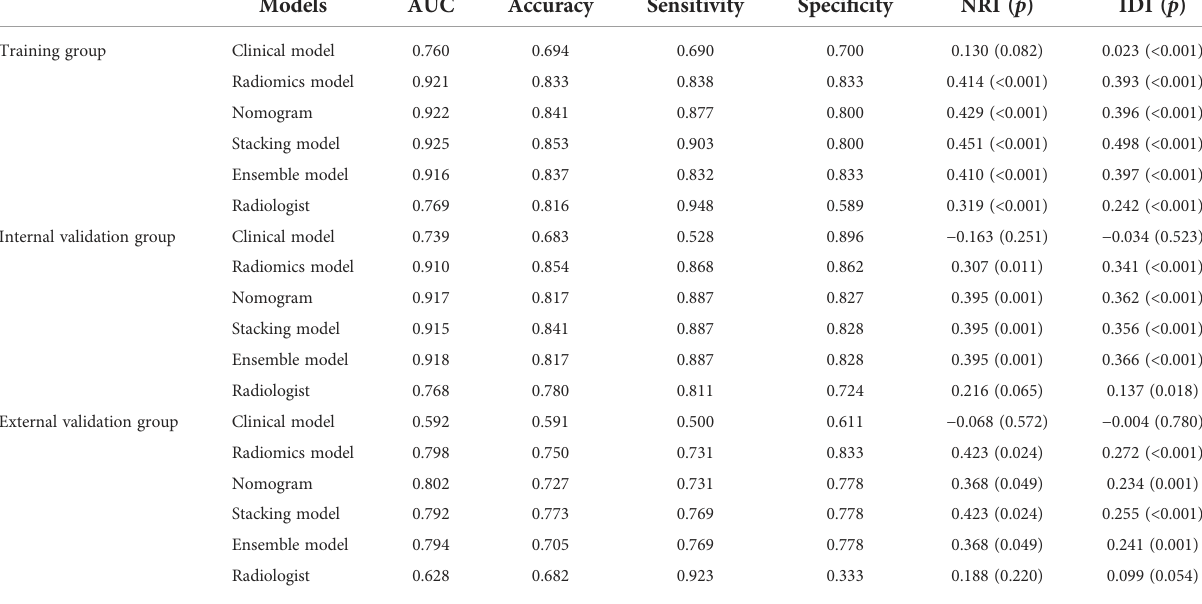
TABLE 4 Diagnostic ef fi ciency and clinical bene fi t of different